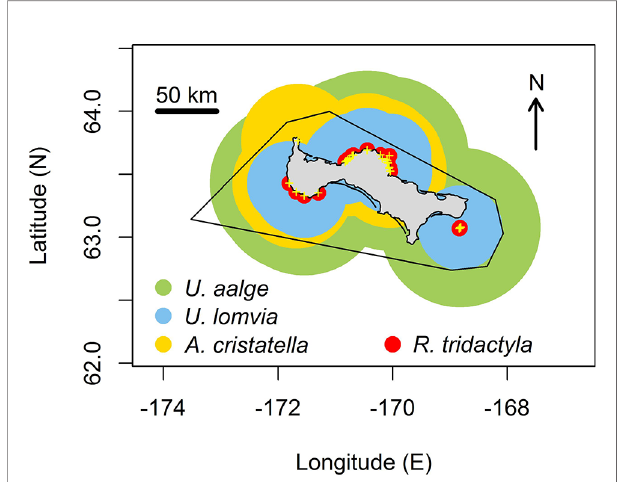
FIGURE 3 | Projected foraging range of seabirds, based on foraging tracks collected in this study, for 25 colonies (yellow crosses) around St. Lawrence Island for common murres (green areas), thick-billed murres (blue areas), crested auklets (gold areas) and black-legged kittiwakes (red areas). The contour of the ATBA around the island is indicated in black.